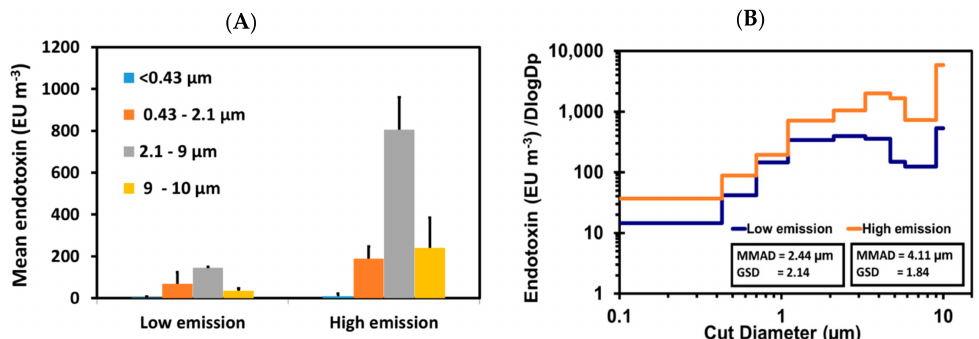
Figure 5. ( A ) Size fractionated endotoxin concentration under different emission scenarios (n = 3 measurements each; Bars = Standard deviation); and ( B ) size distribution of endotoxin during low and high emission (n = 1 measurement